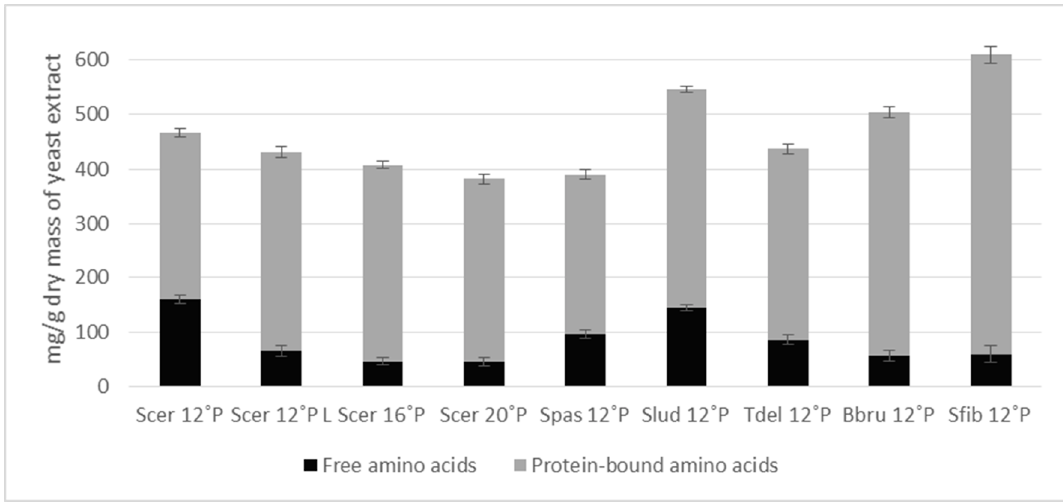
Figure 1. Free and protein-bound amino acids in yeast extracts made from spent yeast of beer production via mechanical disruption method (ultrasonic sonotrode); influence of original gravity (12 ◦ P, 16 ◦ P, 20 ◦ P), time of yeast cropping (after primary fermentation vs. after cold beer lagering (L)) and yeast strain (Scer, Spas, Slud, Tdel, Bbru, Sfib); for results of ANOVA and pairwise t test, see text; data are expressed as mean values ± confidence limits.